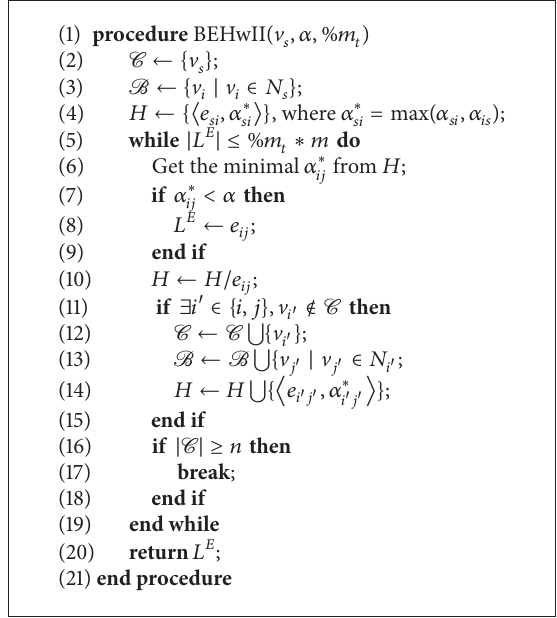
Algorithm 1: BEHwII